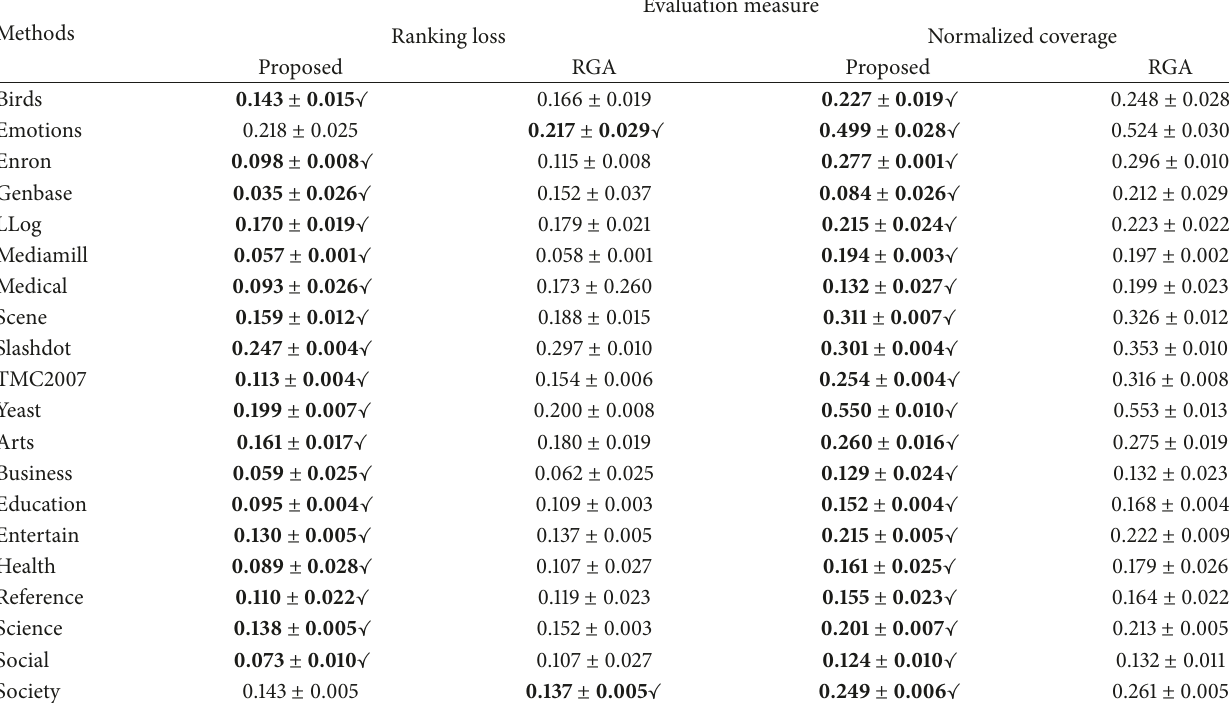
Table 4: Comparison results for multilabel feature selection methods in terms of ranking loss and normalized coverage (mean ± std. deviation). The ✓ symbol indicates the method that achieves the best performance for each